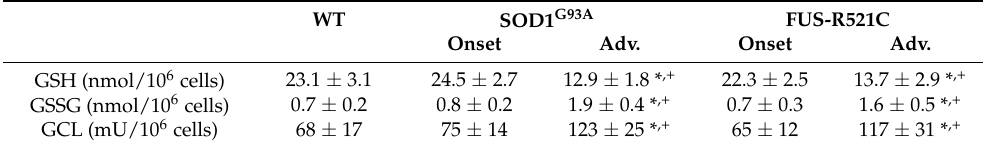
Table 5. GSH/GSSG levels and GCL activity in astrocytes isolated from wild-type and ALS mice. Data are mean values ± SD for n = 9. * p < 0.01 comparing values obtained in ALS models versus the wild- type controls. + p < 0.01 comparing advanced state of progression versus onset of symptomatology. WT SOD1 G93A Adv.